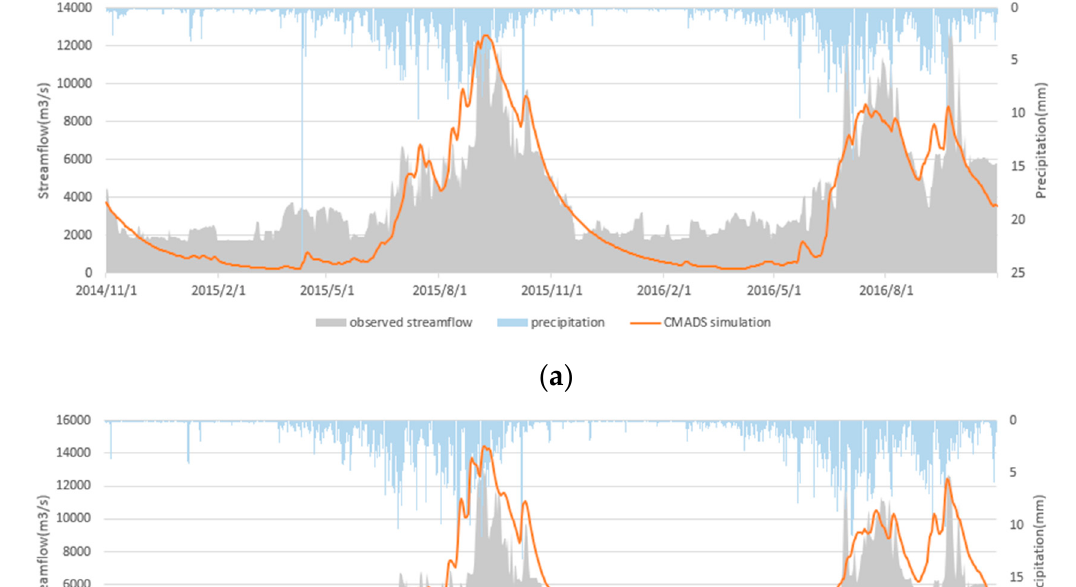
Table 4. Comparison of hydrological model simulation accuracy.